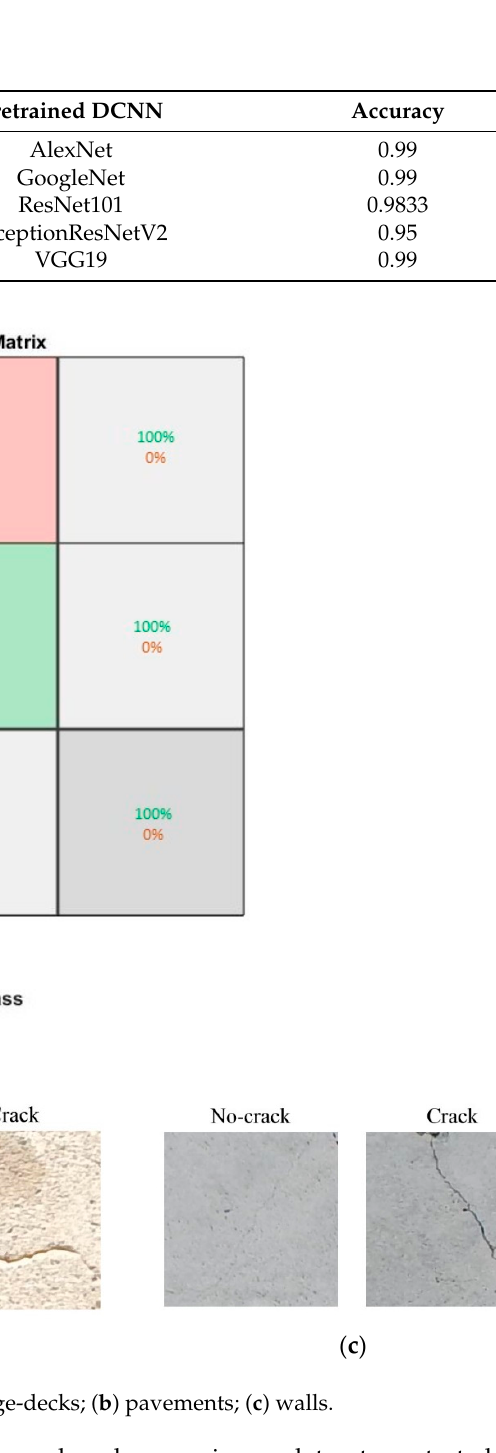
Table 7. Accuracies of pretrained DCNNs.